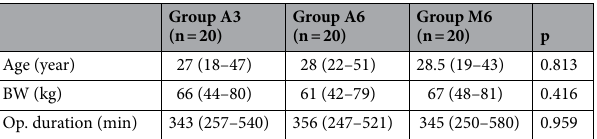
Table 1. The age, BW, and operation duration between the groups (median,